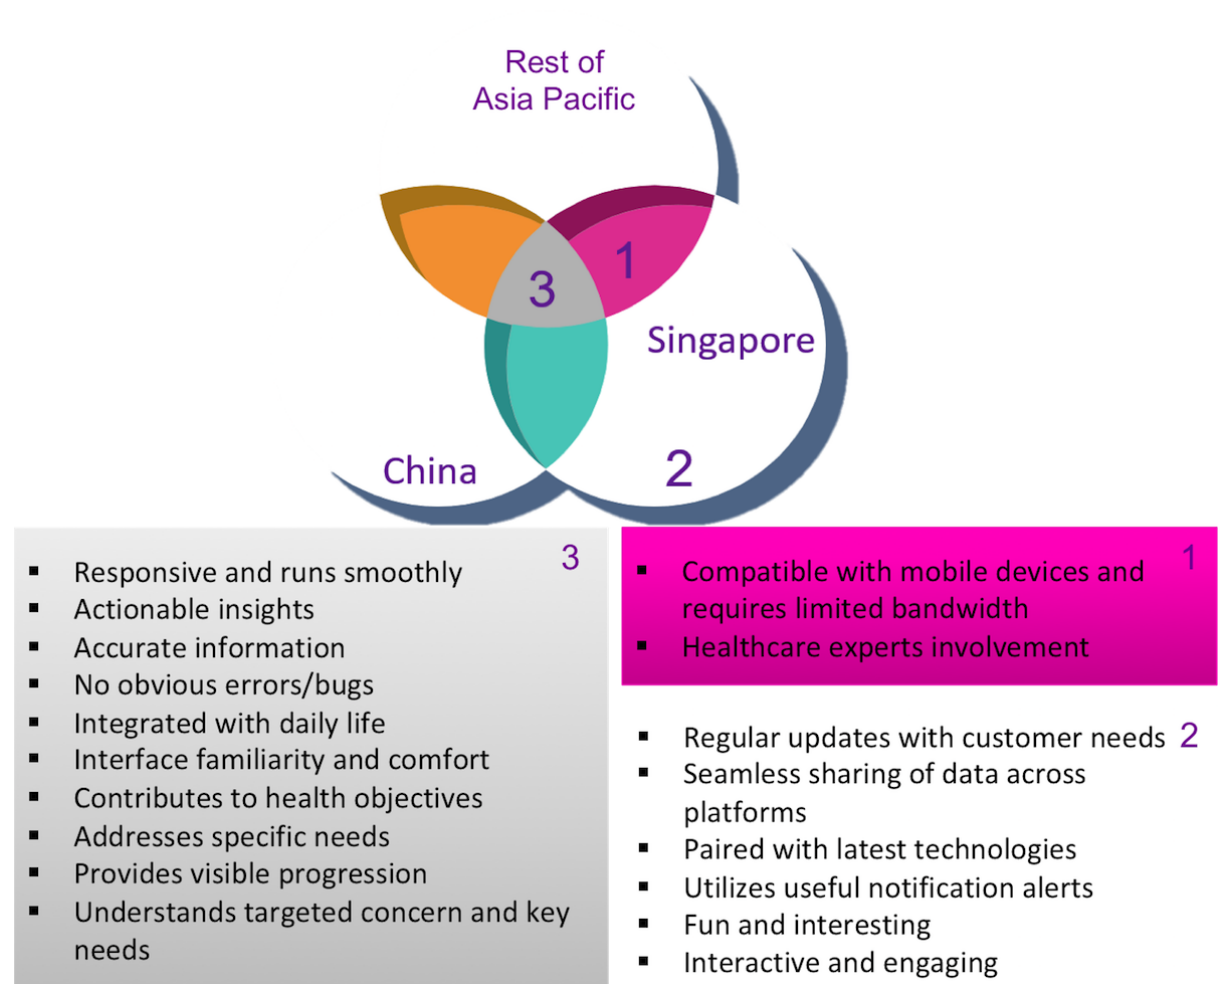
Figure 11. Demographic comparisons of mHealth insiders' top